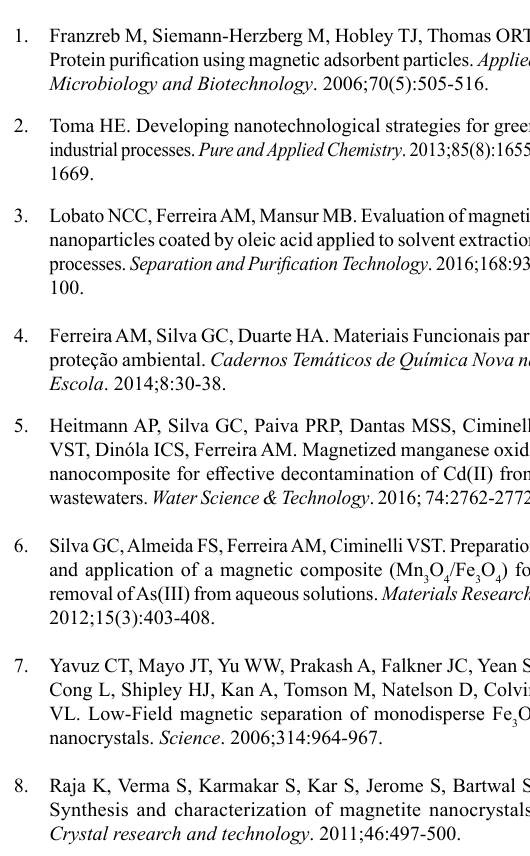
The magnetic hysteresis curves of samples